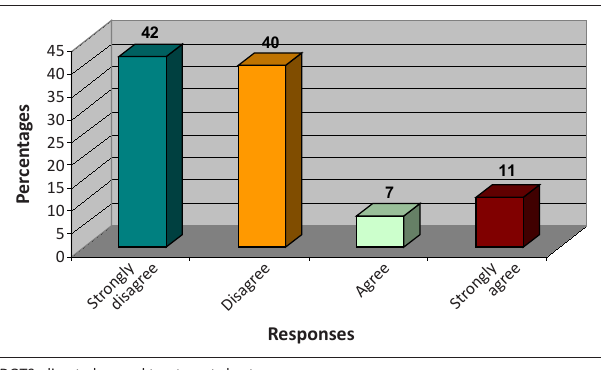
DOTS, direct observed treatment short. FIGURE 3: Respondents’ views on the statement that community nurses have not been fulfilling a role in prevention of tuberculosis since direct observed treatment short ( n = 57).